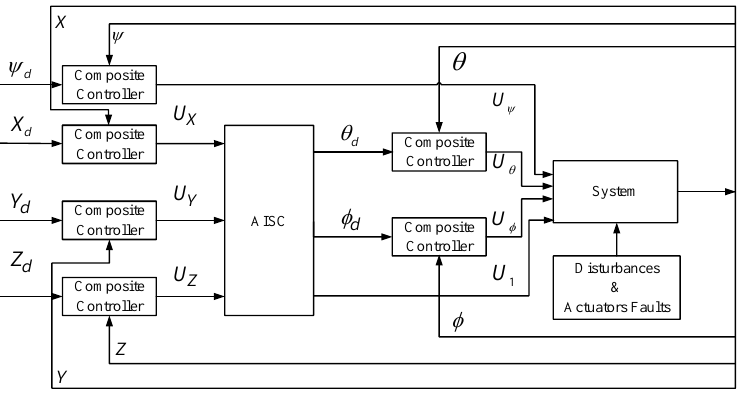
Figure 2. The control structure of QUAV (AISC: attitude inverse solution calculation).